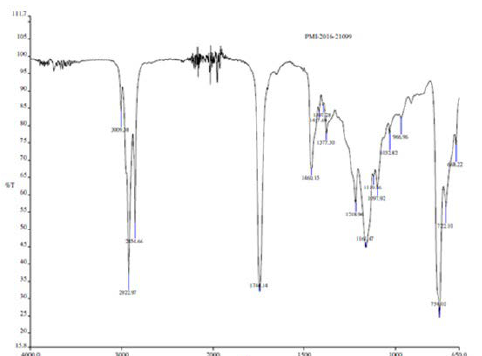
Fig. 7. Fourier transform infrared spectroscopy analysis of biosurfactant by Candida tropicalis RA1.